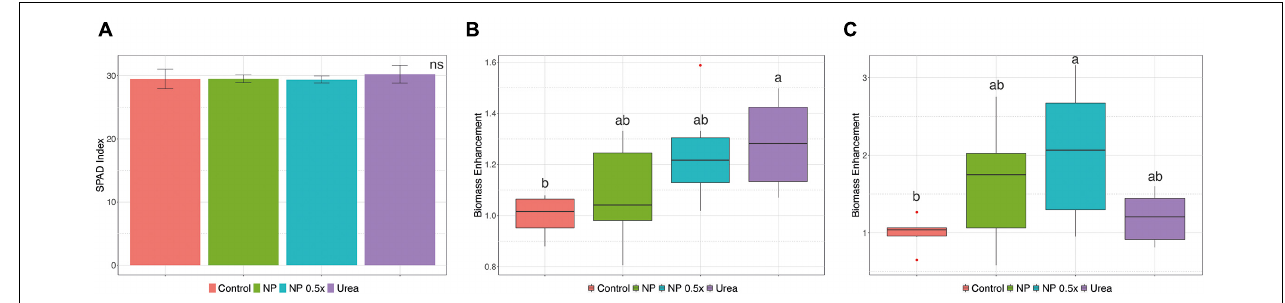
FIGURE 2 | Growth parameters. (A) SPAD index, (B) shoot, and (C) root biomass enhancement of cucumber plants either not treated (control) or supplied with 1 mM Urea, NP, or NP.5 × . The assessments have been carried out at harvest (i.e., 7 days after the treatments as depicted in Supplementary Figure 2C ) on at least six independent biological replicates. For the SPAD index, data are reported as means ± SE. The biomass enhancement depicts the fold-change variation in the DW biomass of treated cucumber plants as compared to control ones. Different letters indicate significantly different values as determined by one-way ANOVA with Tukey post hoc tests ( P < 0.05).